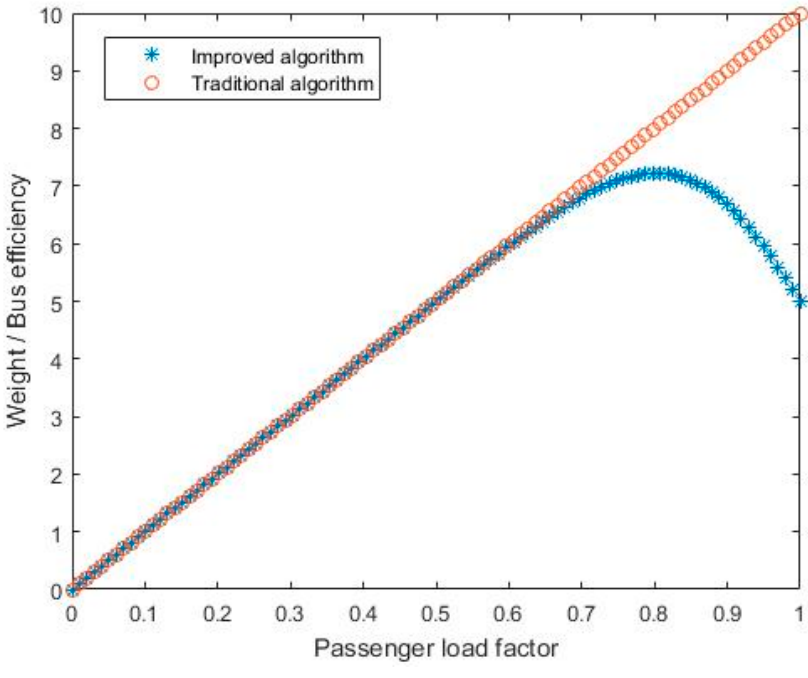
Figure 3. Two kinds of bus efficiency.